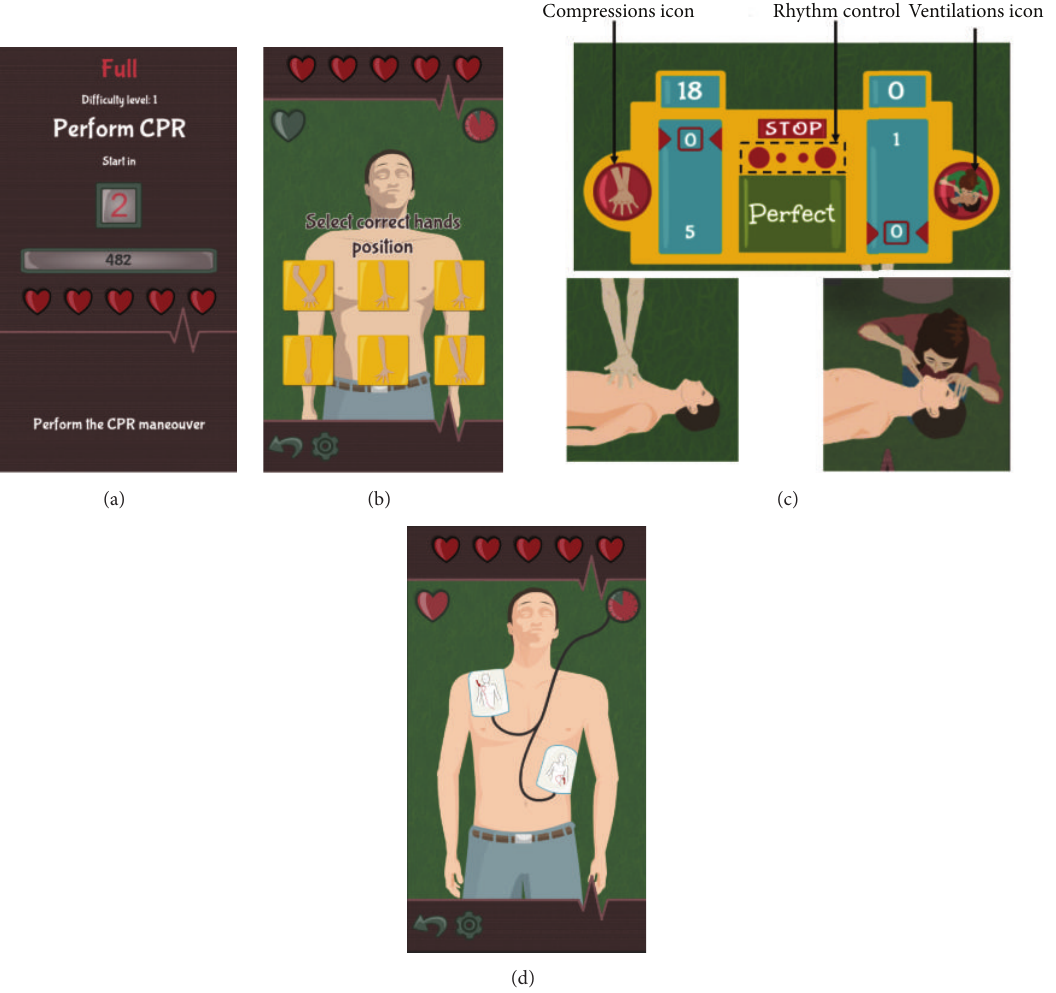
Figure 10: Game screens corresponding to the Perform CPR mini game. (a) The init screen. (b) The icon to select correct hand positions. (c) The menu to perform compressions and ventilations. (d) Defibrillator patches after performing CPR maneuver.